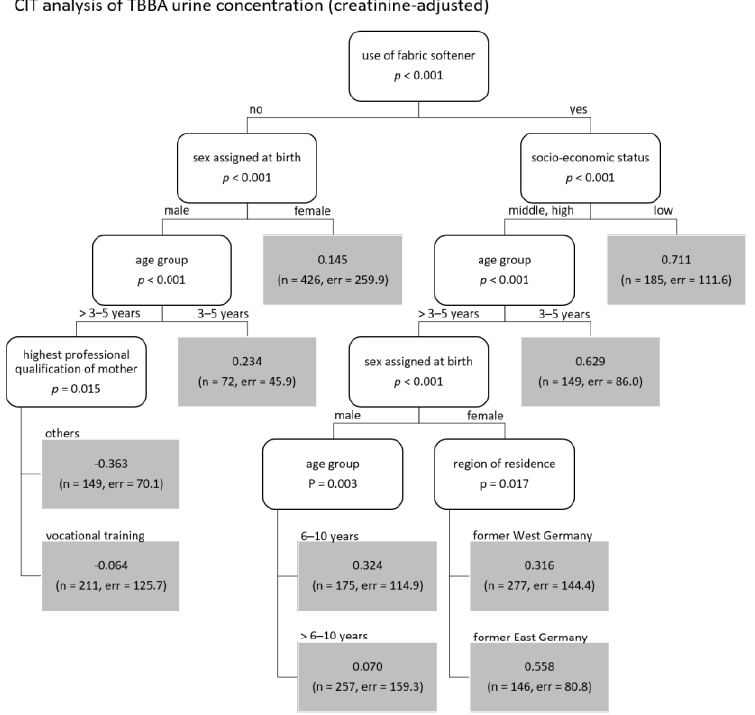
Figure 2. CIT results for creatinine-adjusted TBBA and lysmerol urine concentrations for all participants.